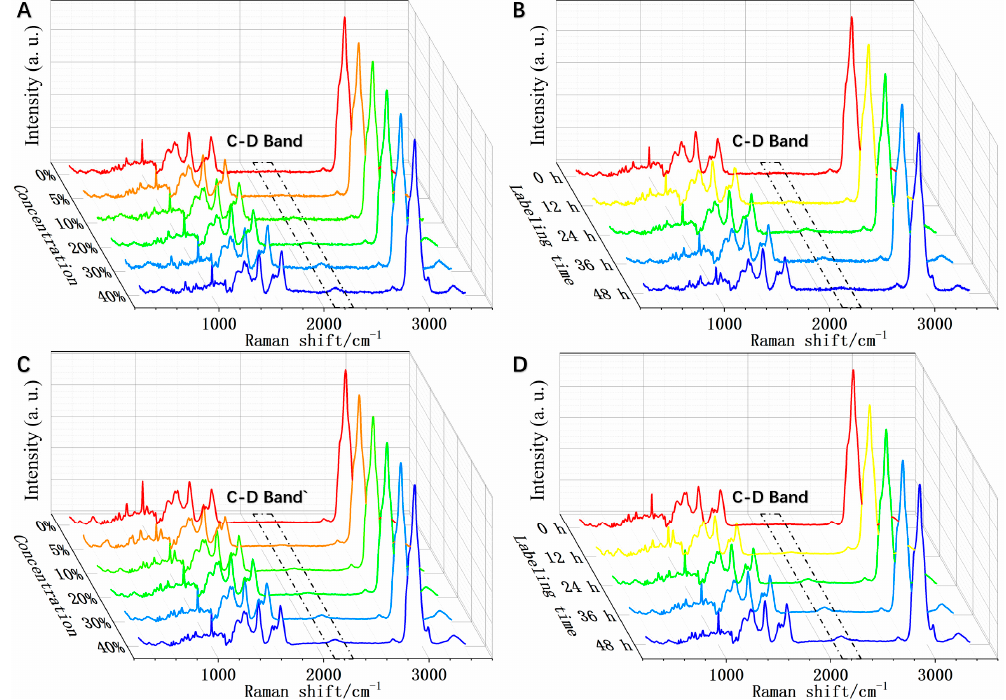
Figure 2. Single-cell Raman Spectra (SCRS) of cells after being incubated in D 2 O-containing medium. ( A ) HCC827 cells incubated with various D 2 O concentrations for 24 h. ( B ) HCC827 cells incubated in 30% D 2 O for different labeling time. ( C ) MCF-7 cells incubated at various D 2 O concentrations for 24 h. ( D ) MCF-7 cells incubated in 30% D 2 O for different labeling time. The lines represent the average intensity ( n ≥ 100). The spectra were baseline corrected and normalized with the intensity of the phenylalanine peak at 1003 cm − 1 .